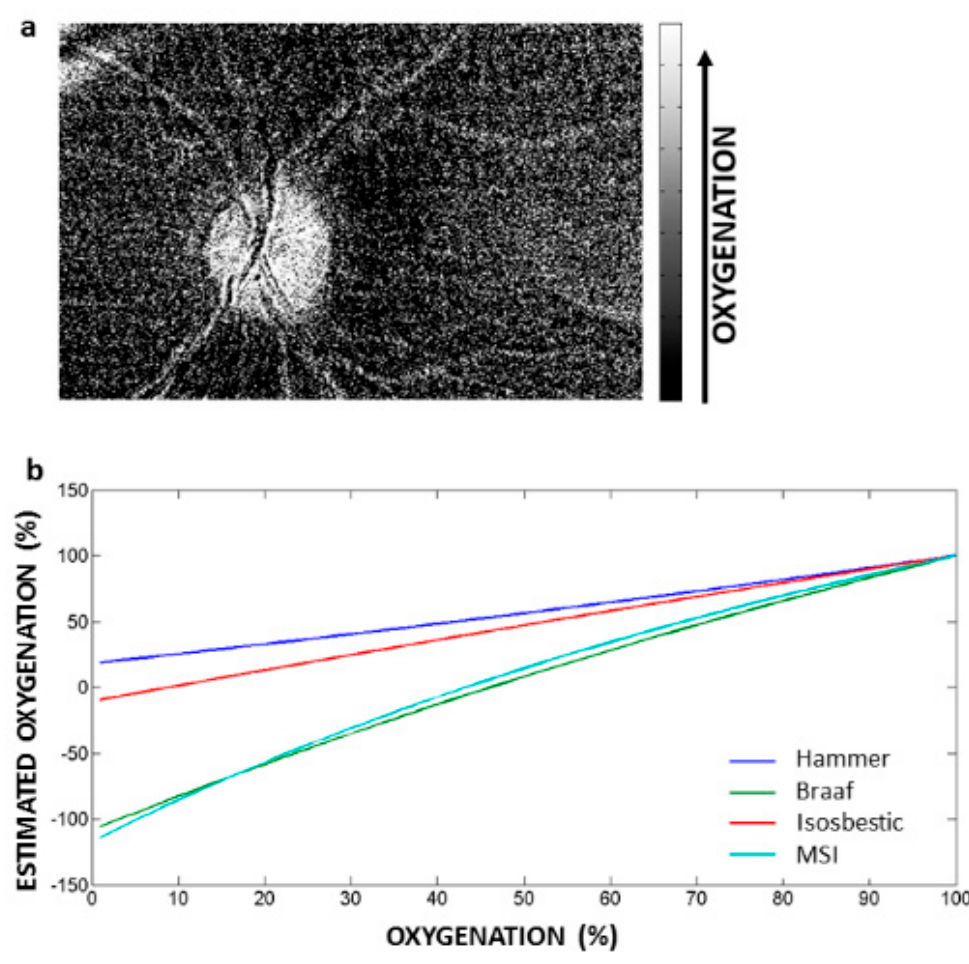
Figure 7. Visualisation of relative retinal oxygen saturation. ( a ) Determination of the relative oxygen saturation by comparing the measured reflectance with reference spectra of fully oxygenated and deoxygenated blood (in grayscale). The algorithm was applied to measured reflectance data of the ocular fundus of unknown oxygen saturation, at the wavelengths selected for the MSI. ( b ) Simulation of oxygen saturation levels using reflectance at the selected wavelengths. Estimated oxygenation values at the wavelength settings used underestimated the relative oxygen saturation measurements when plotted against low absolute levels of oxygen saturation. At higher levels of estimated oxygen saturation, the values were similarly independent of wavelength.